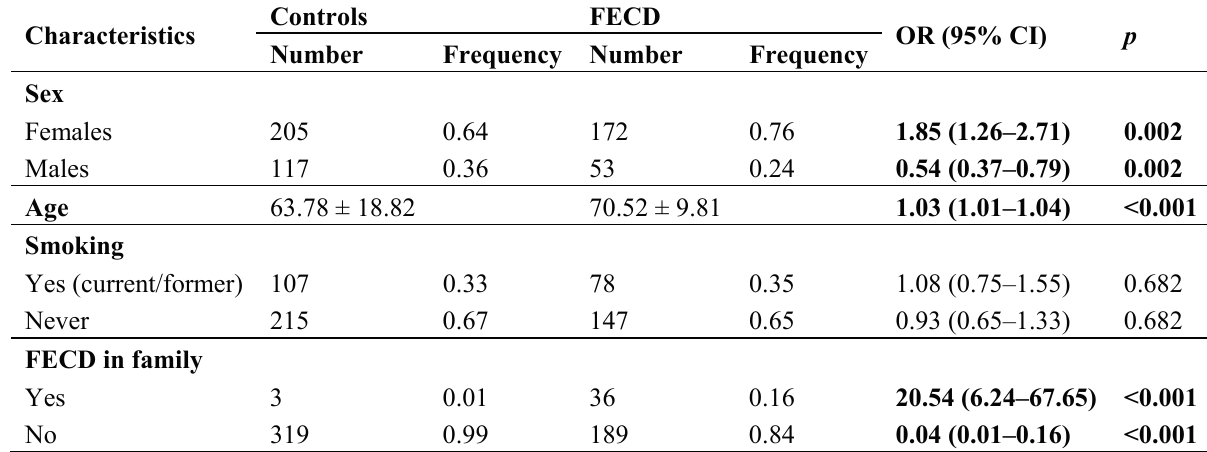
Table 3. Risk of Fuchs endothelial corneal dystrophy (FECD) associated with age, sex, tobacco smoking, co-occurrence of visual disturbances, body mass index (BMI), heart and vascular diseases, allergies and family history of